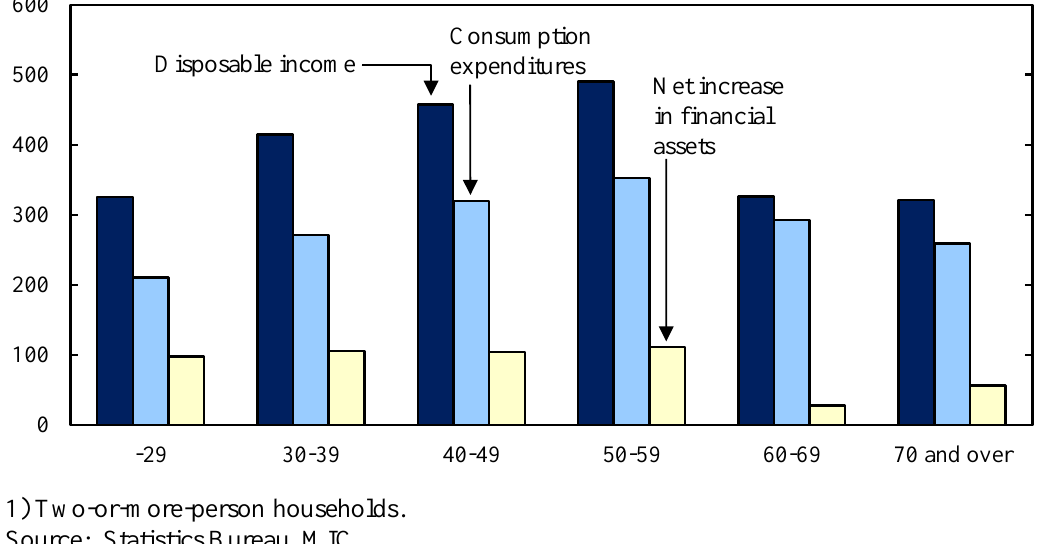
Figure 13.4 Average Monthly Family Income and Expenditures by Age Group of Household Head (Workers' households 1) )